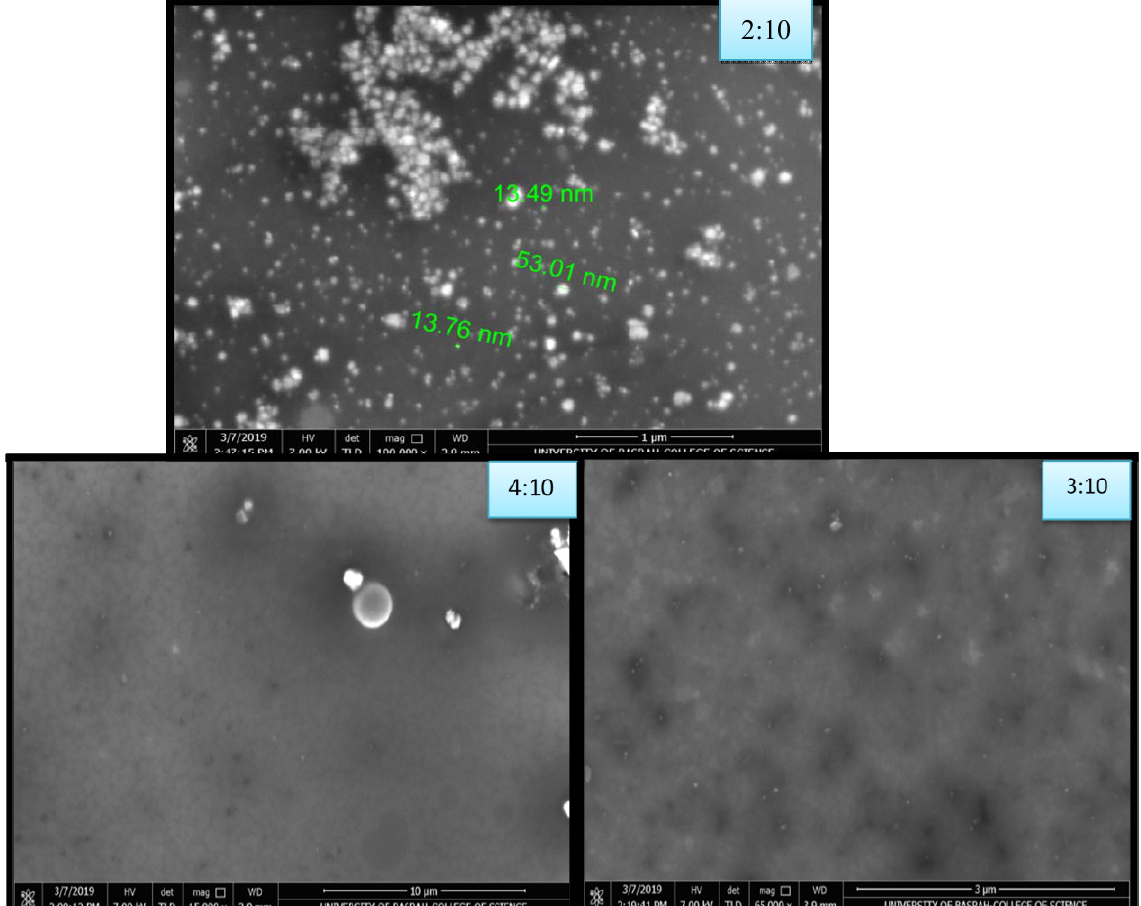
Fig.7: FESEM images of AgNPs which synthesized by changing the mixing ratio.